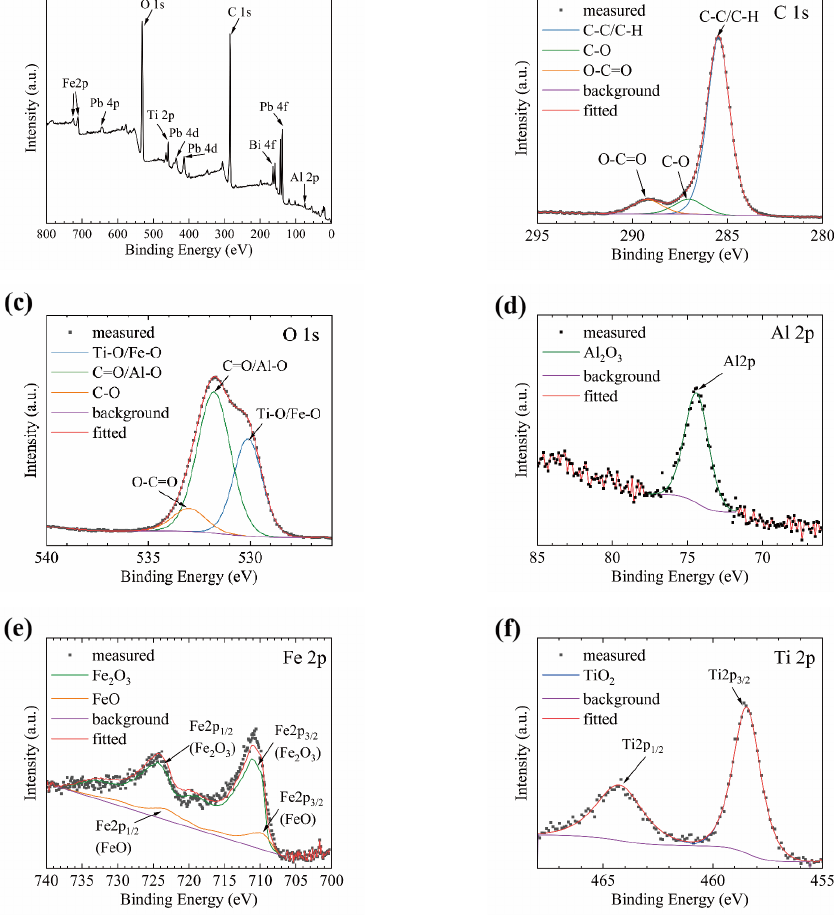
Figure 11. XPS results of the 0.2 wt.% Y 2 O 3 coating surface after 1000 h LBE corrosion: ( a ) XPS survey spectrum; XPS spectra of ( b ) C1s; ( c ) O 1s; ( d ) Al 2p; ( e ) Fe 2p; ( f ) Ti 2p.